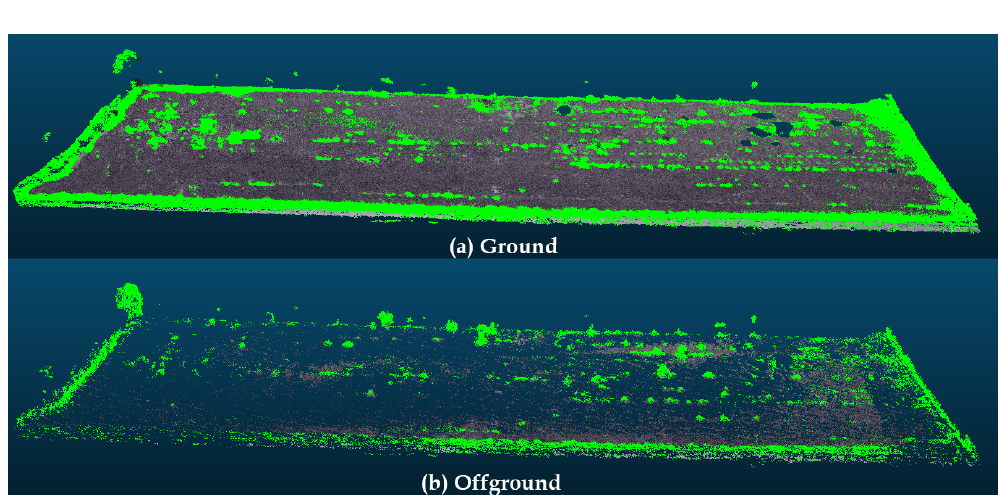
Figure 15. Classified vegetation show marked in